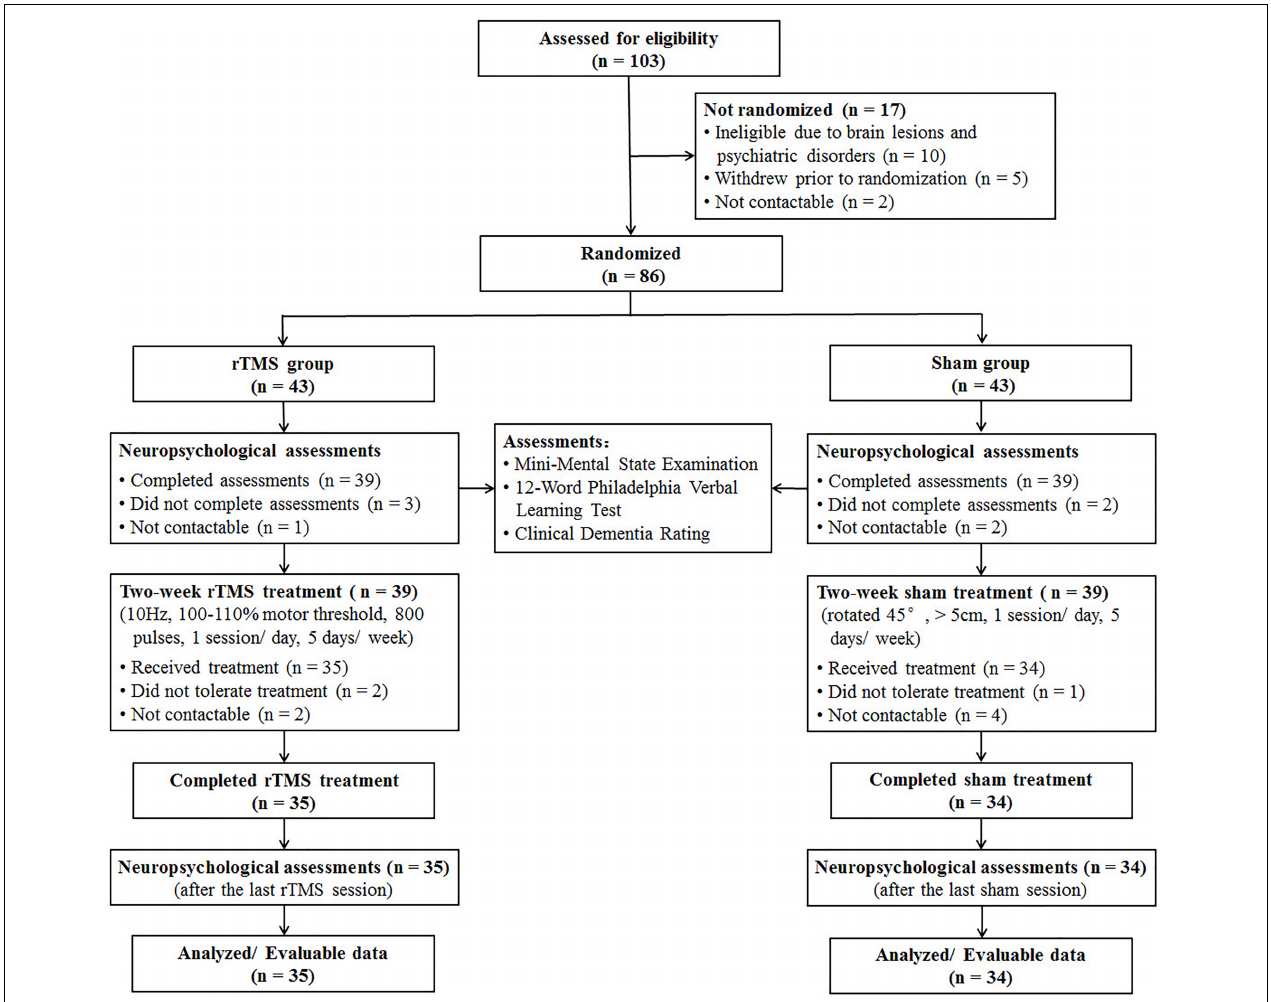
FIGURE 1 | CONSORT diagram of patients with Alzheimer’s disease in a double-blind, sham-controlled study of rTMS.